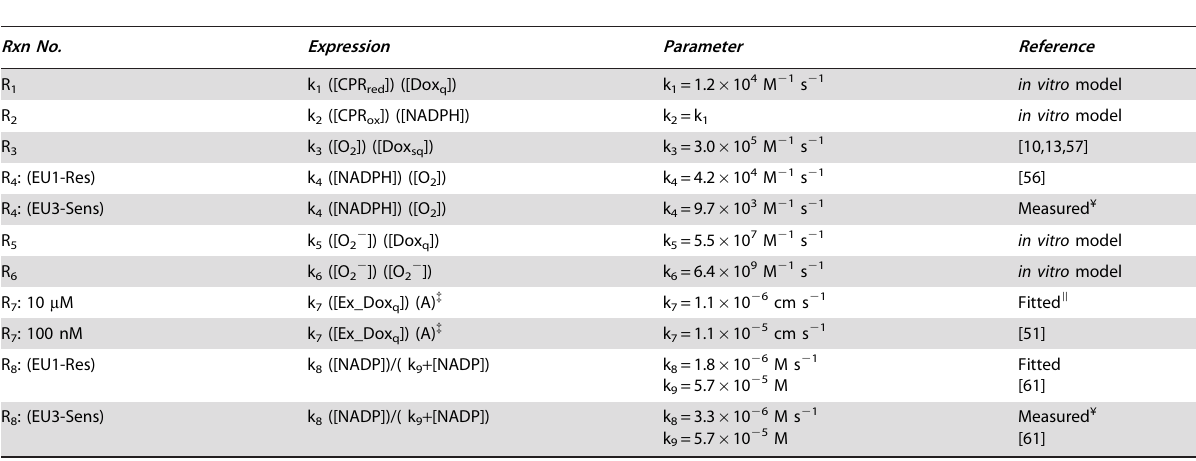
Table 4. Reaction expressions and parameter values for the in vivo Dox models.